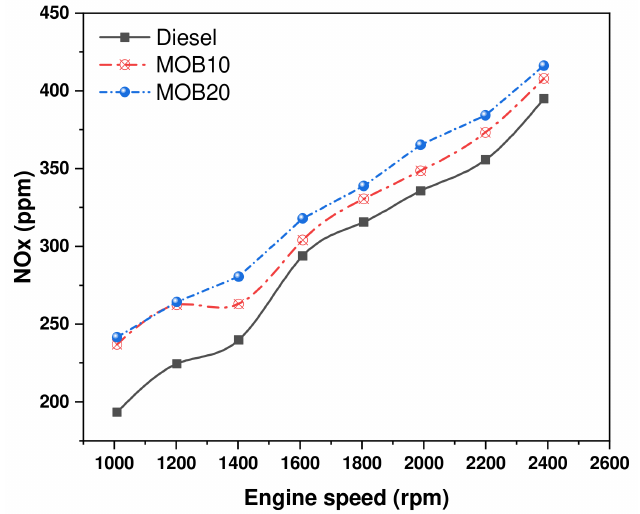
Figure 8. Nitrogen oxides emissions of Moringa oleifera biodiesel blends and diesel at various engine speeds.